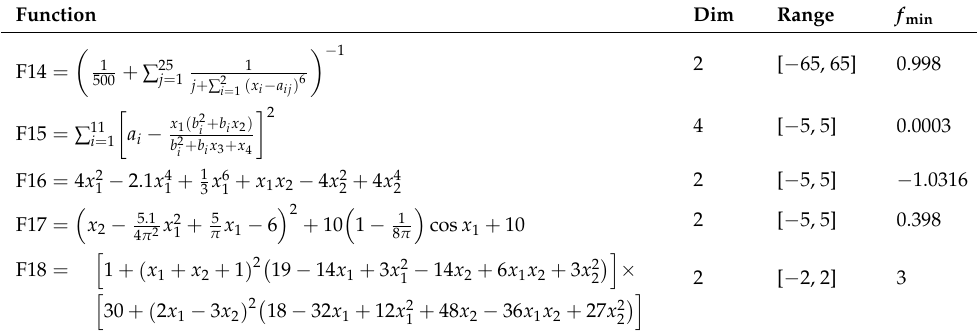
Table A3. Fixed-dimension benchmark